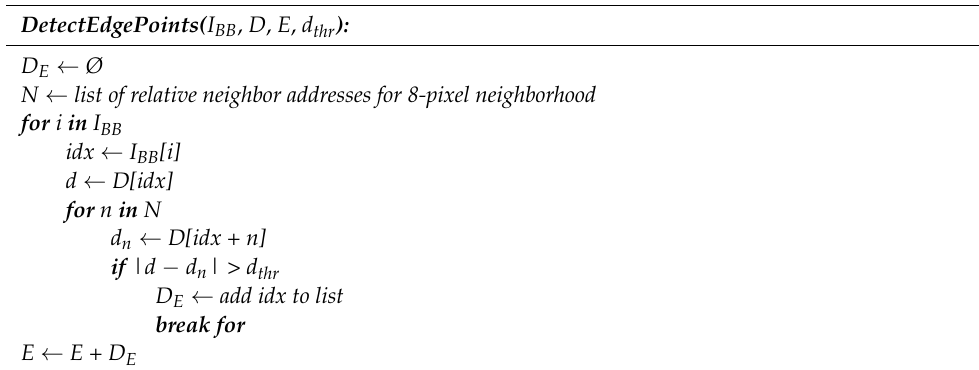
Algorithm 1. Edge Point